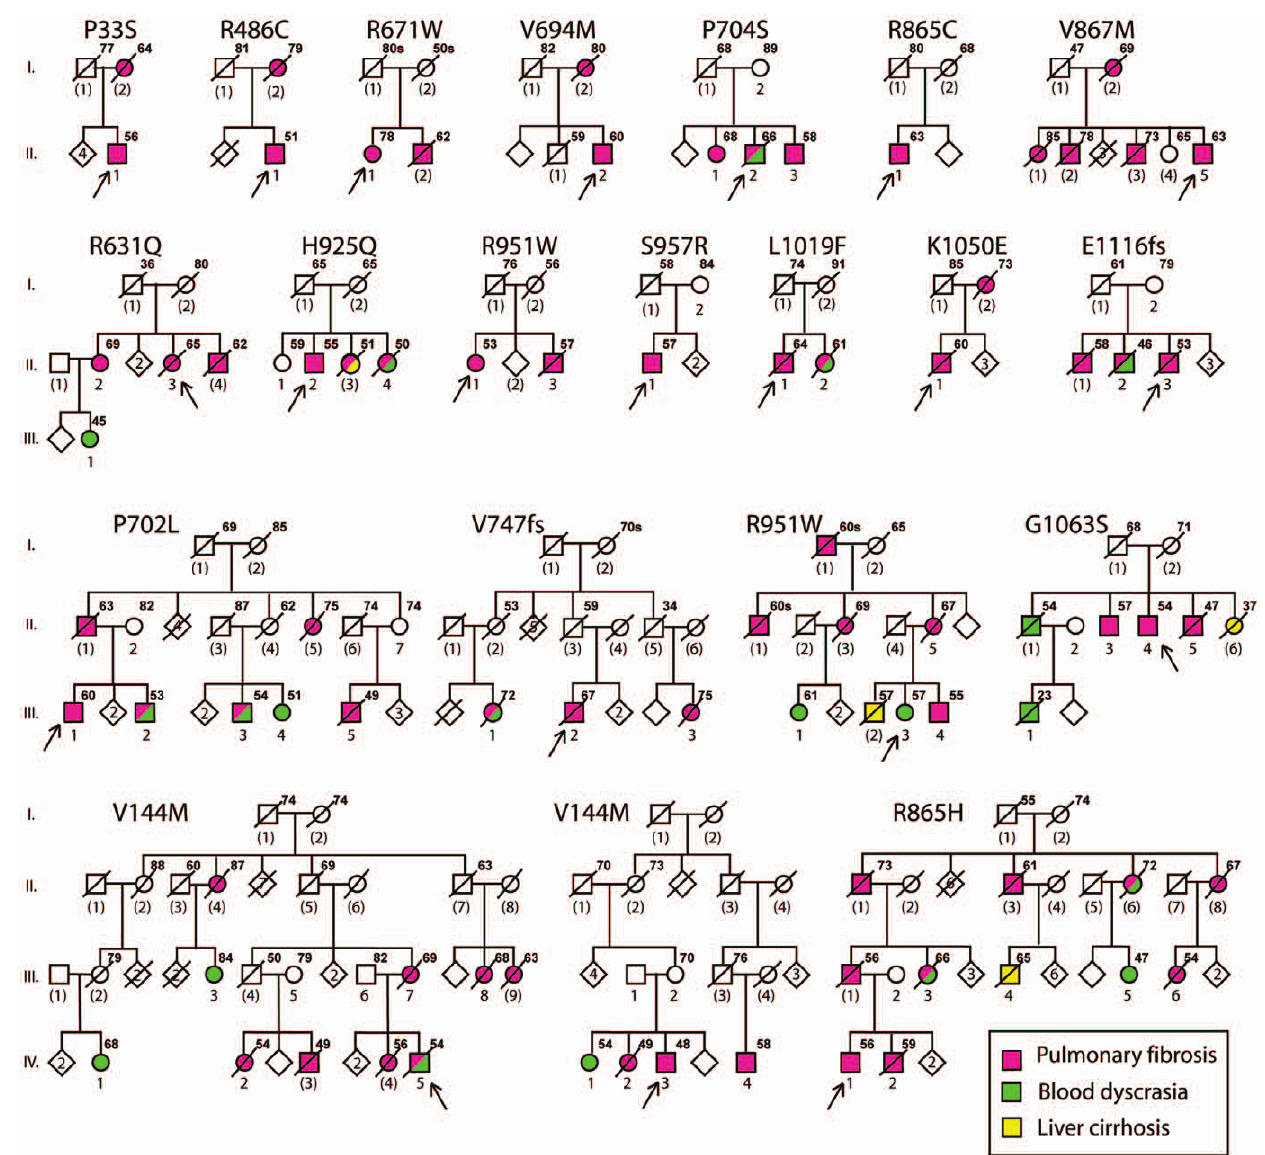
Figure 1. Abridged pedigrees of kindreds with heterozygous mutations in the gene encoding the protein component of telomerase ( TERT ). The arrow indicates the index case. Circles represent females; squares represent males. Symbols with a slash indicate deceased subjects. Individuals with pulmonary fibrosis, blood dyscrasias and liver cirrhosis are indicated by red, green, and yellow symbols, respectively. Roman numerals indicate the generation. Numbers in parentheses indicate individuals for whom no DNA sample was available. The age at the time of consent or the age of death is indicated to the upper right of each symbol. The predicted amino acid changes that result from the TERT mutations are listed above each family. Some of the pedigrees have been modified to hide identifying features.